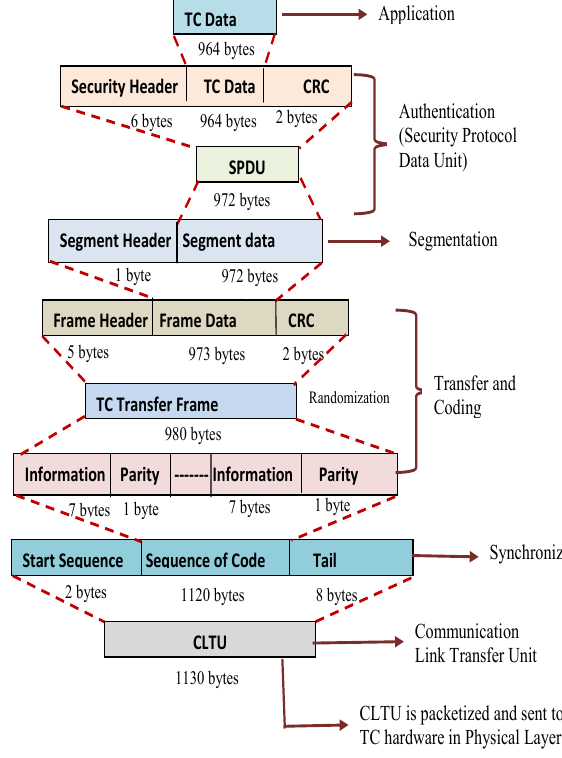
Figure 7. TC Frame Generation